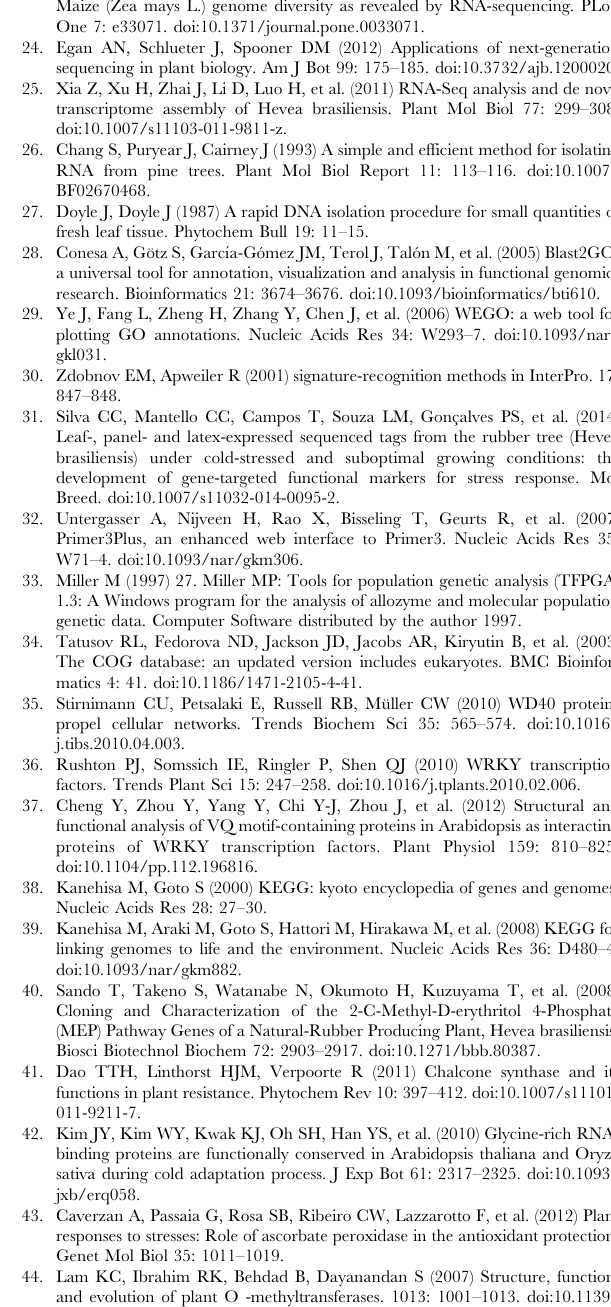
Table S5 The 20 most highly expressed genes in the GT1 and PR255 genotypes. Table S6 Characterization of all the developed SNP markers. The table presents the SNP markers that were developed for H. brasiliensis , including the corresponding primer sequences, annealing temperatures, and expected and observed products sizes in 1.5% agarose gel electrophoresis.